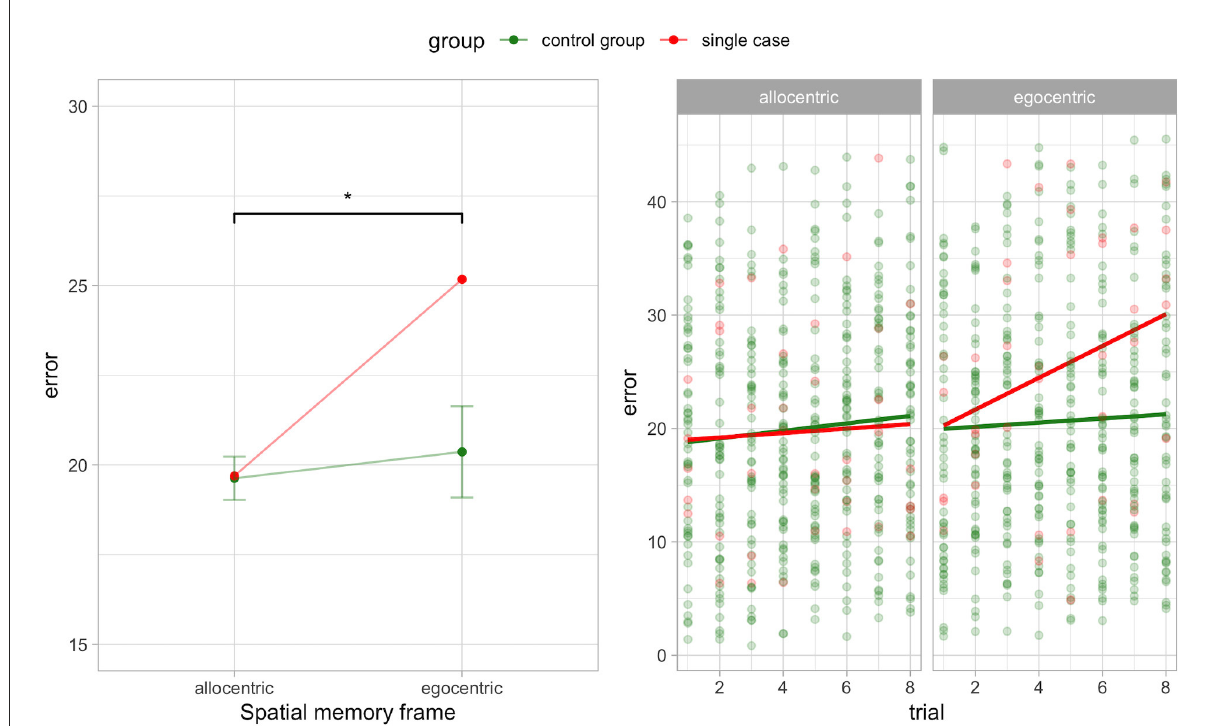
FIGURE1 Egocentric-allocentric dissociation (left panel) and testing effect (right panel) for the egocentric and allocentric frame in A.A. and the control group (PD without hallucinations). Mean and 95% CI are shown for the control group in the left panel. * p < 0.05.